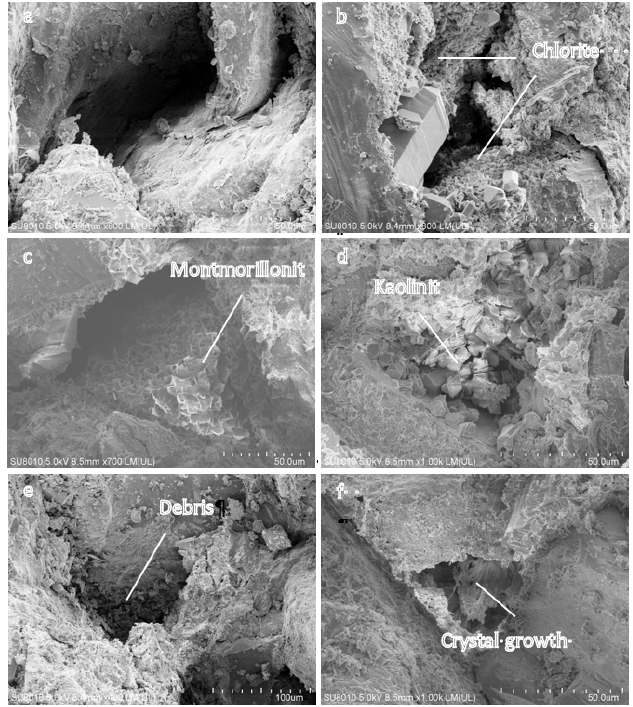
Figure 10. SEM images of the pores before ( a , b , c ) and after ( d , e , f ) the flooding experiments. ( a ) smooth surface and without filling; ( b ) fluff spherical chlorite attached to the surface; ( c ) alveolate montmorillonite attached to the surface; ( d ) flaky kaolinite loosely accumulated in the pores; ( e ) throat blocked by debris; ( f ) crystals grown in the pores.